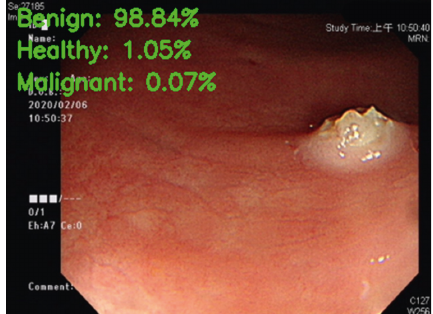
Figure 12: Tumor risk assessment result: the risk of benign tumor is